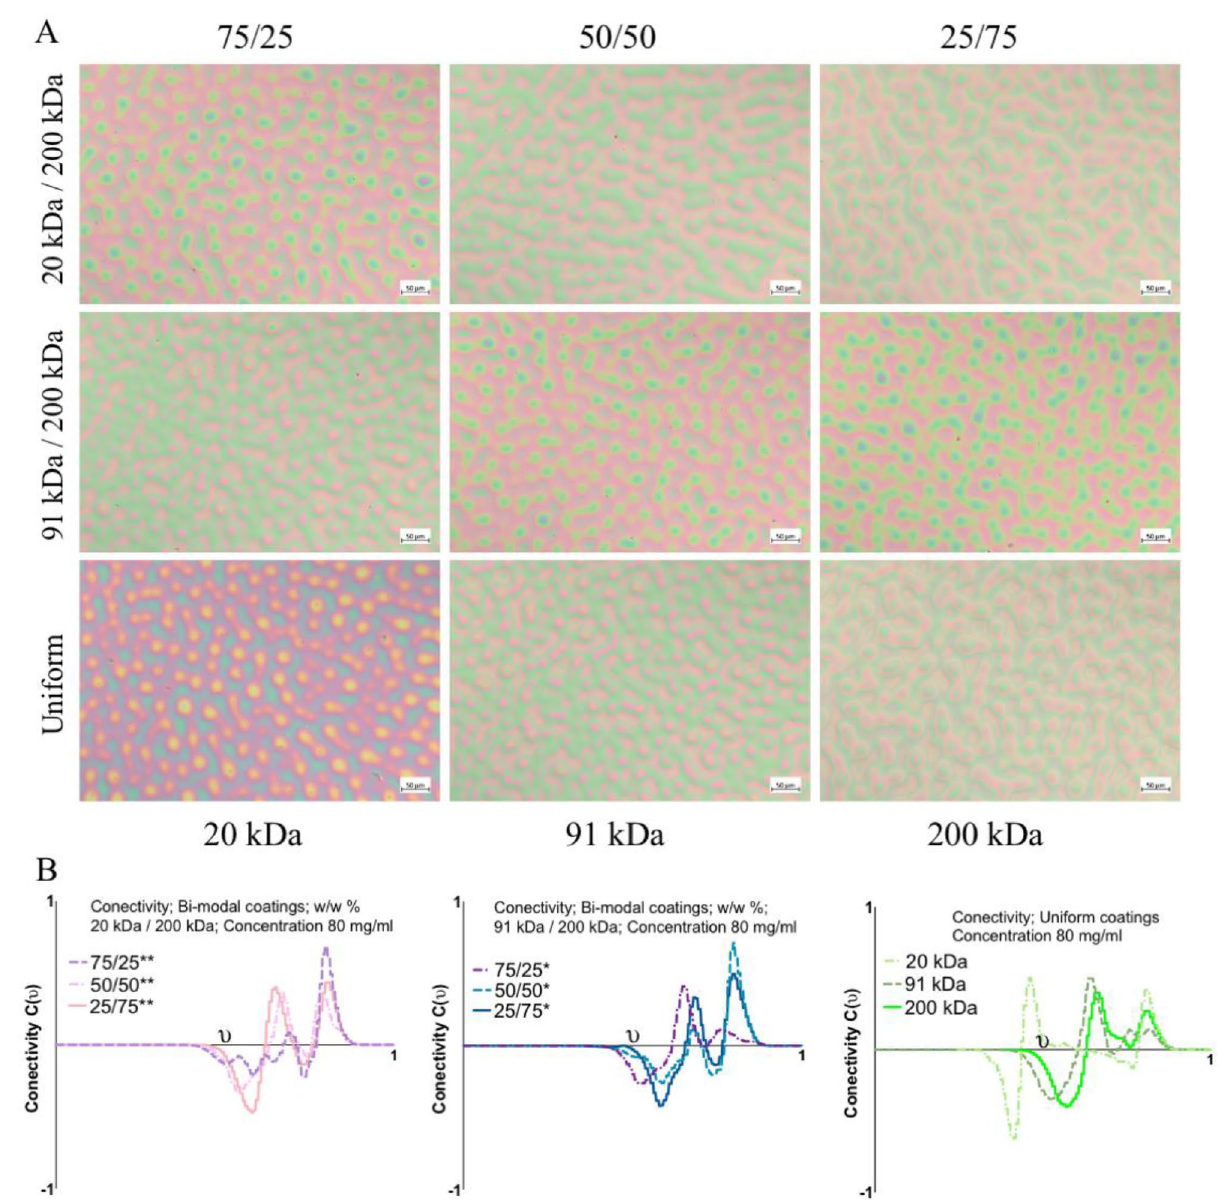
Figure 5. ( A ) Optical images of coatings spun from 80 mg/ml. The ( B ) Minkowski connectivity C(ν) of the coatings spun from 80 mg/ml, where ν represents the threshold for image binarization. The values on the axis were normalized to